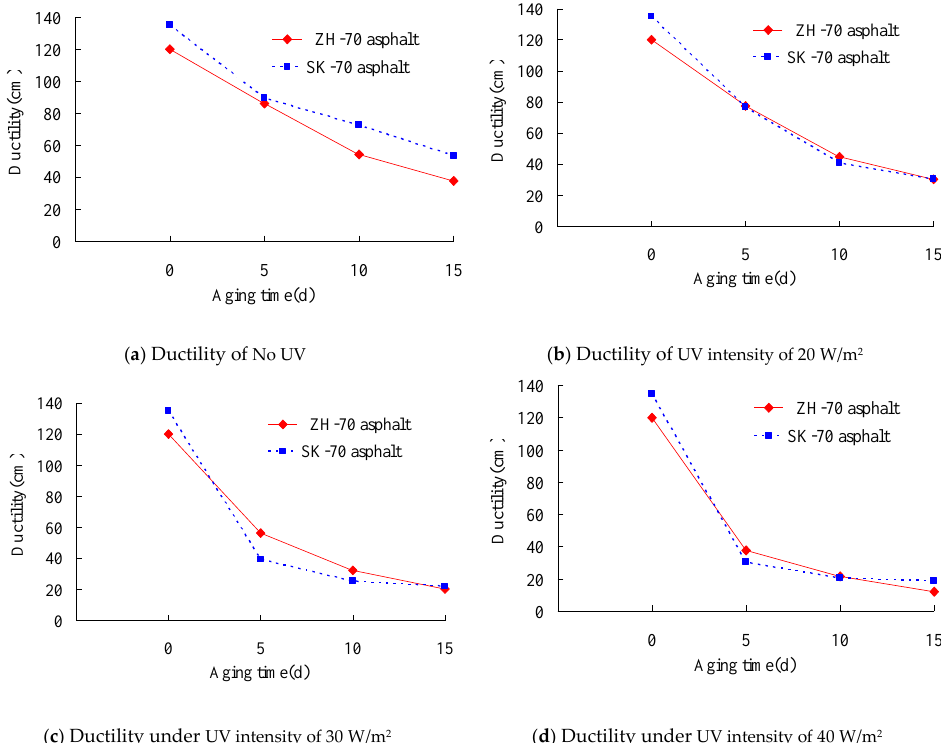
Figure 3. Relationship between ductility and aging time